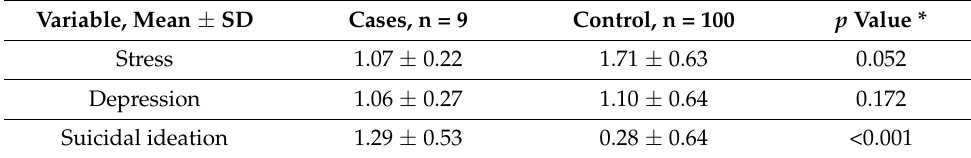
Table 3. Comparison of stress, depression and suicidal ideation between